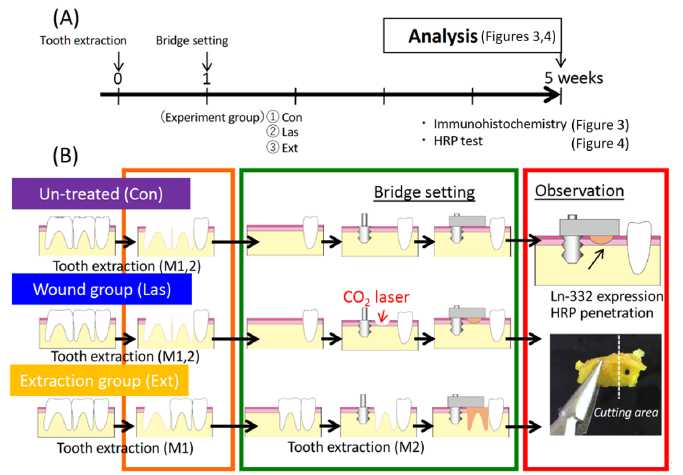
Figure 2. Experimental bridge model and experimental protocol. ( A ) Experimental protocol for the in vivo study. ( B ) Experimental groups; Con: mucosa healing after tooth extraction; Las: mucosa treated with a CO 2 laser after tooth extraction; and Ext: mucosa after a tooth